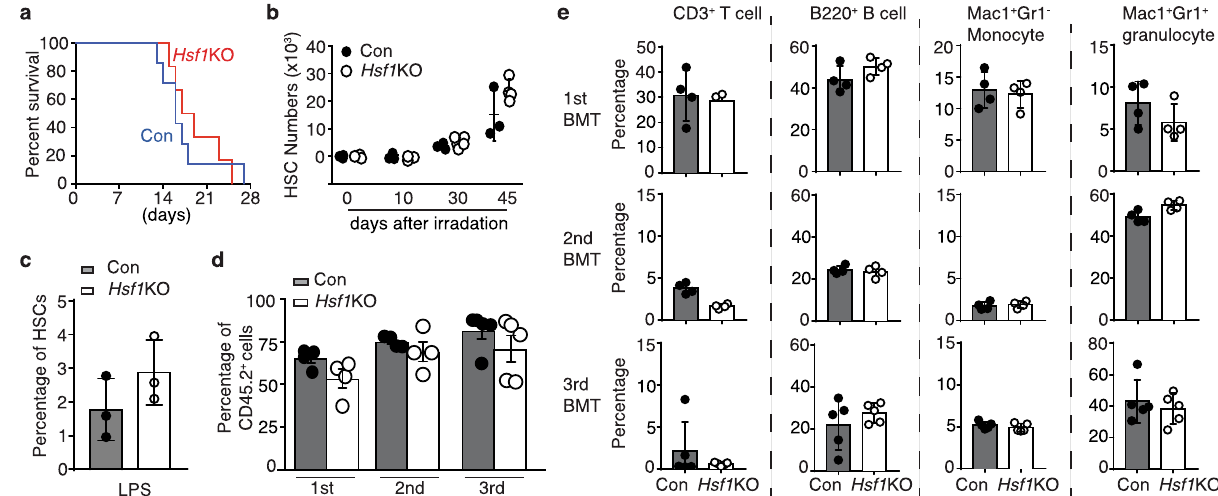
Fig. 2 | HSF1 is dispensable for stressed hematopoiesis. a Kaplan – Meier survival curves of Hsf1 fl / fl (Control, Con) or Hsf1 fl / fl Vav-Cre + ( Hsf1 KO) mice treated with weekly doses of 5-FU (150mg/kg, IP, Con n =7 mice; Hsf1 KO, n =6 mice). b HSC (de fi ned as Lin − cKit + Sca1 + CD150 + CD48 − ) numbers of Con or Hsf1 KO mice at dif- ferent time points after sublethal (6.5Gy) radiation (Con, n =3 mice at each time points, Hsf1 KO, n =3miceatDay0and10, n =5miceatDay30and n =4atDay45). c Percentages ofHSCs in Con or Hsf1 KO mice (3 mice/group) treatedwith 35 μ g of LPS twice (48h apart) and analyzed 24h after the second injection. d Donor